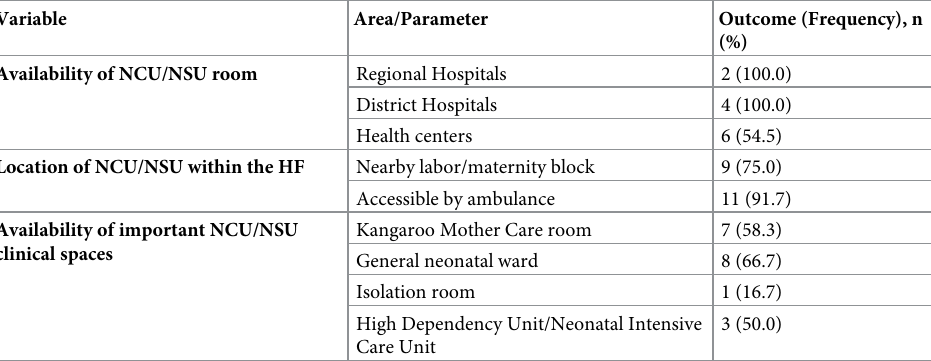
Table 1. Availability of NCU/NSUs at the HFs (N =